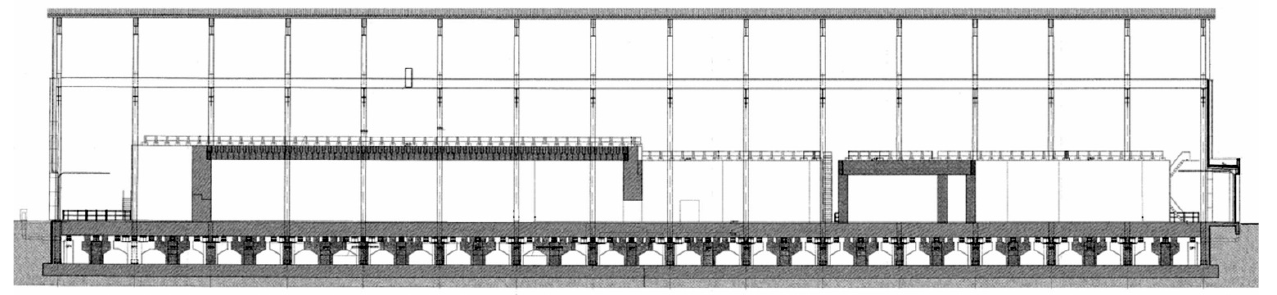
Figure 2. Front view of the facility.